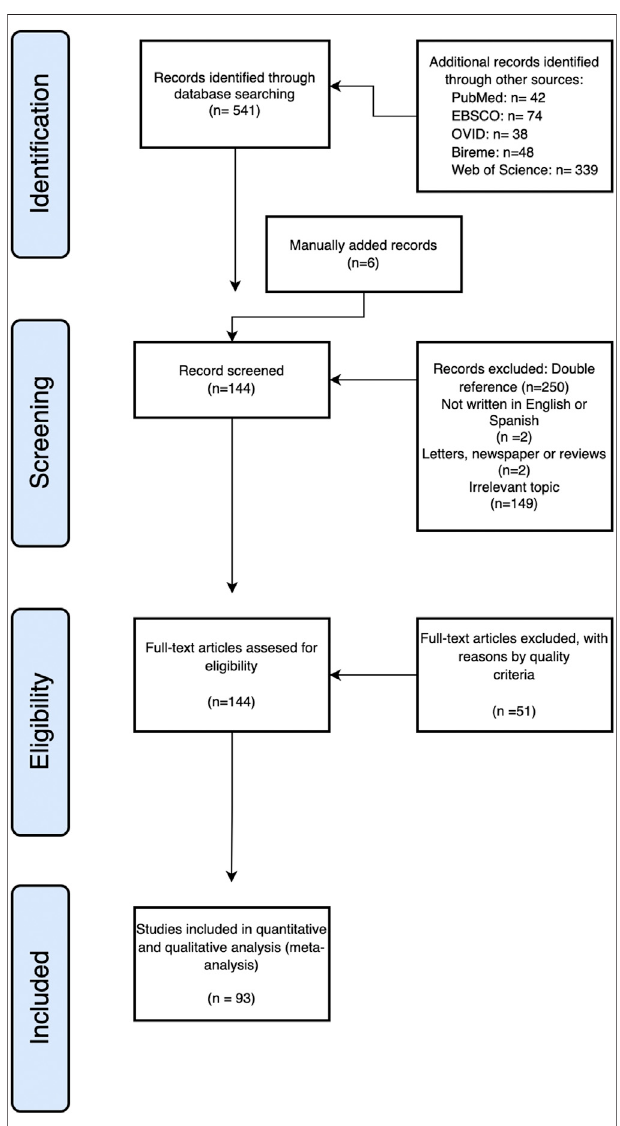
FIGURE 3 | Flowchart of the review process. A PRISMA fl owchart of the systematic review on AI for protein sciences.